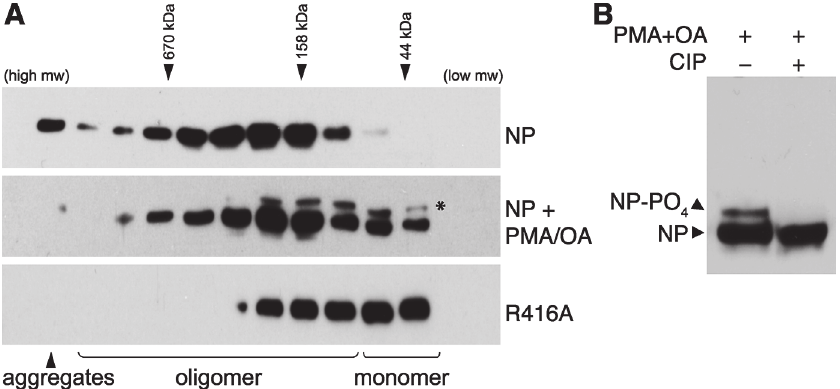
Fig 1. Phosphorylation disrupts self-association of NP. (A) The oligomerization state of influenza virus NP was determined by size exclusion chromatography. Human 293T cells were transfected with plasmids expressing either WT NP or the oligomerization-defective mutant NP R416A. To stimulate phosphorylation, cells were treated with PMA and okadaic acid (OA) or mock treated with DMSO. Whole cell extracts were treated with RNase, fractionated and analyzed by western blotting with anti-NP antibodies. * = stimulation induces the appearance of an NP species that migrates more slowly during SDS-PAGE. Elution peaks for calibration standards are shown. (B) PMA and OA induce NP phosphorylation. Lysates from stimulated cells expressing NP were treated with phosphatase (CIP) and analyzed by western blotting with anti- NP